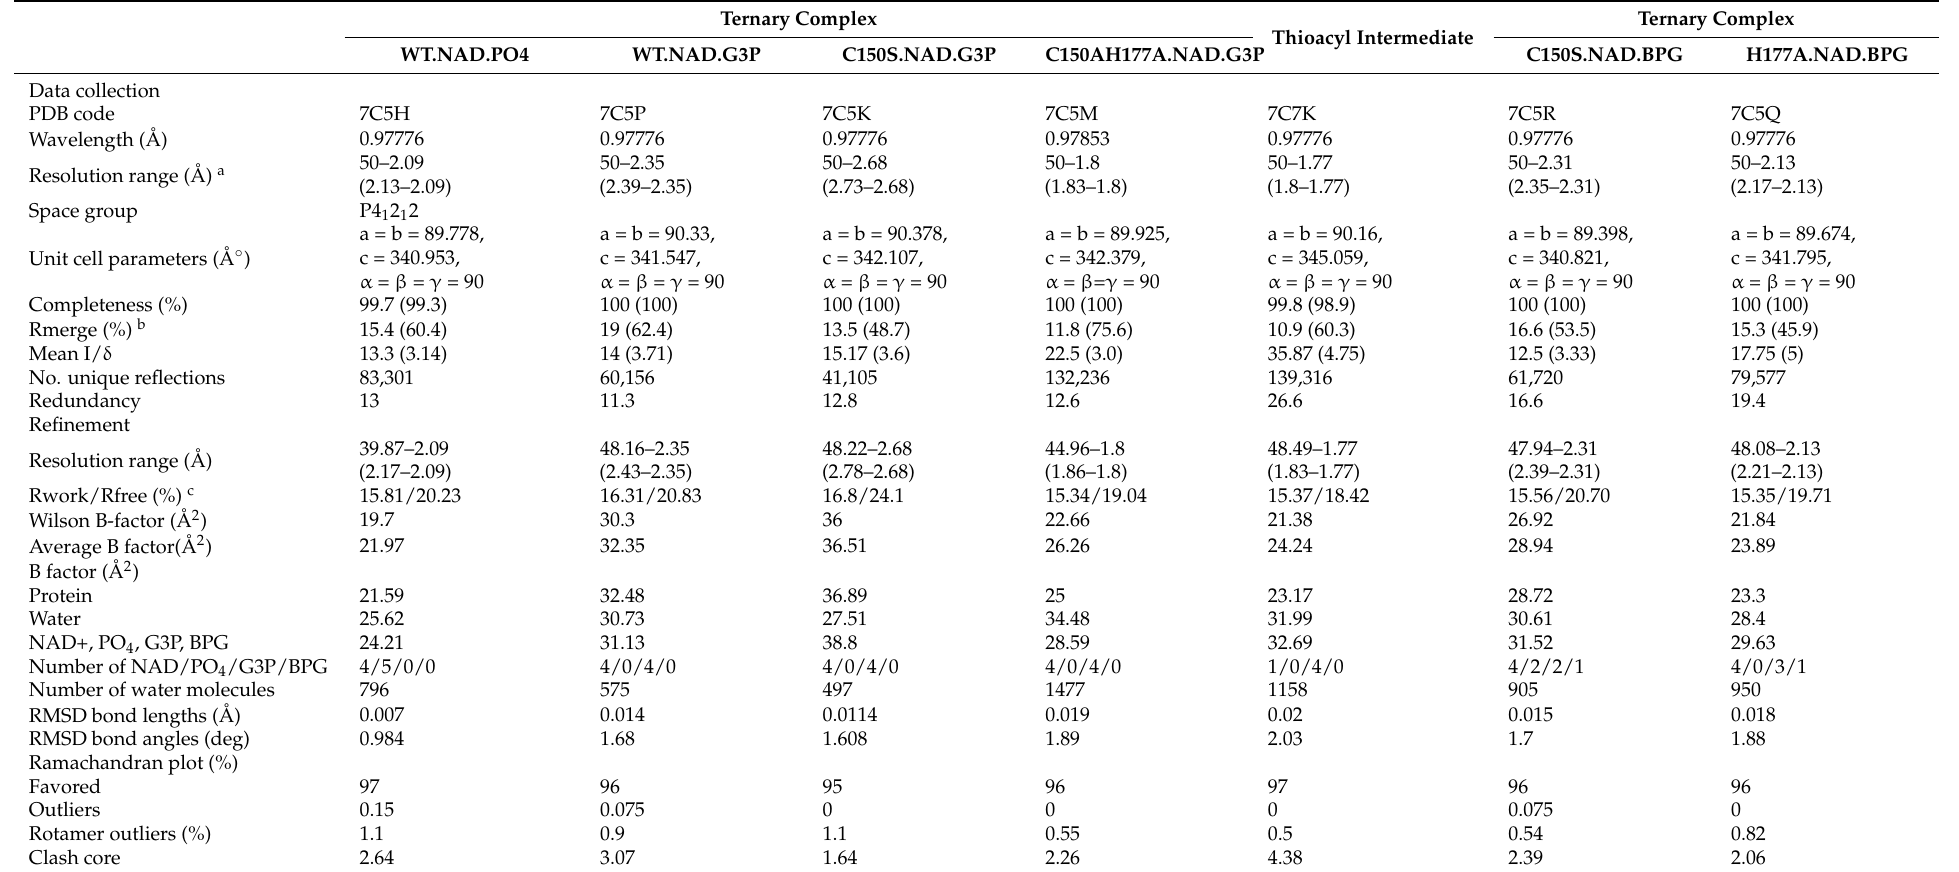
Table 1. X-ray data collection and refinement